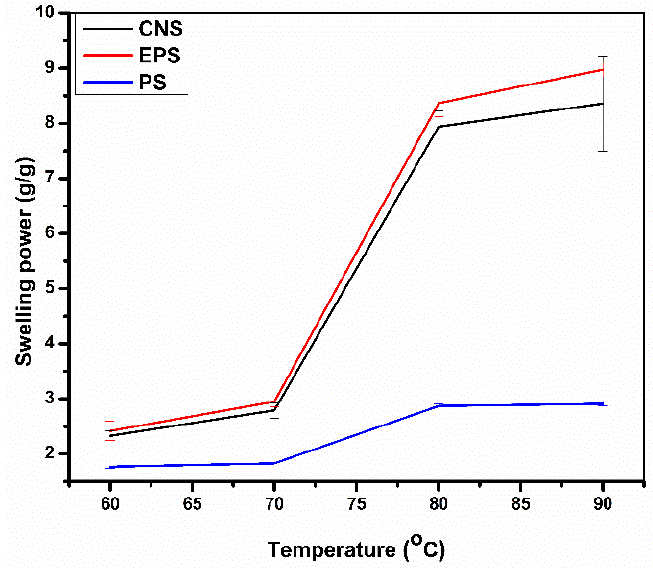
Figure 1. Swelling power of untreated and CLSs.